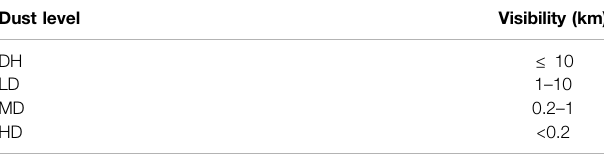
TABLE 4 | Dust level with visibility range [35].